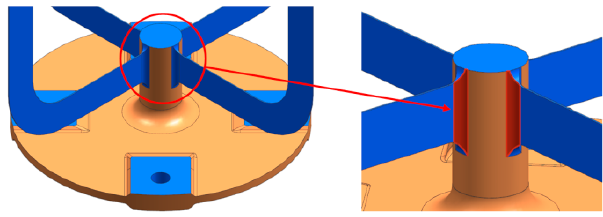
Figure 23. Intersection radius from blade to center rod.